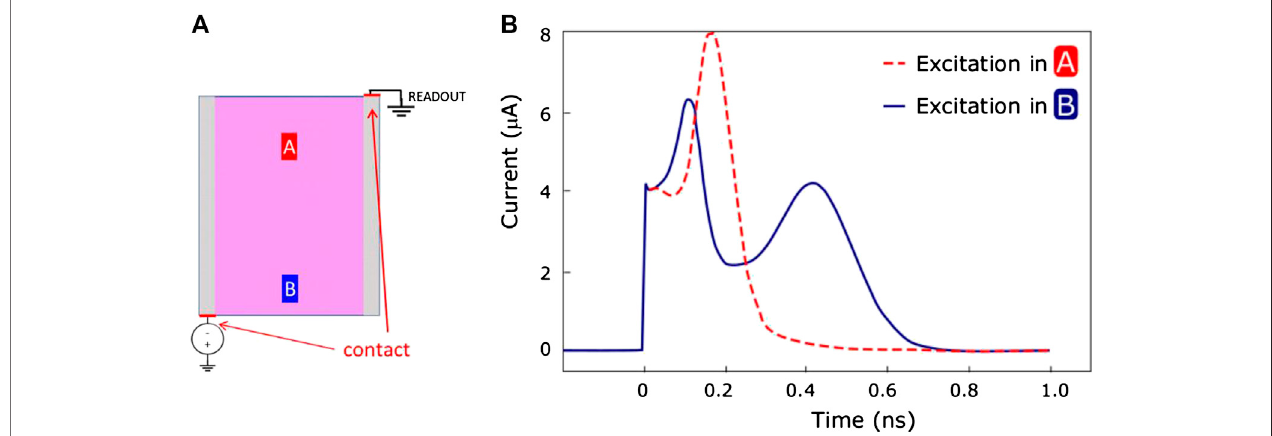
FIGURE2|(B) Thesimulatedcurrentresponsewhenachargeof2.88 fCisreleasedintheelementarycellattwodifferentdepths,atpositionsA(dashedred)andB (solid blue) as shown in (A) .